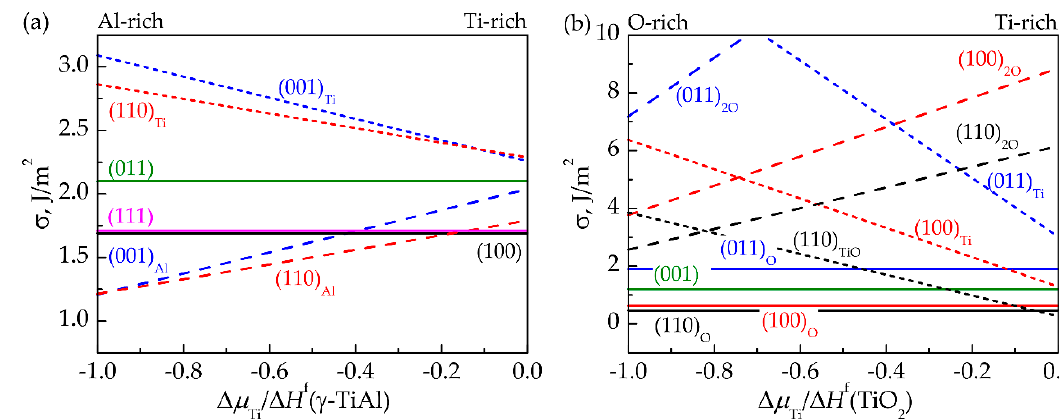
Figure 1. Surface energy of ( a ) γ -TiAl and ( b ) TiO 2 low-index surfaces as a function of the Ti chemical potential.